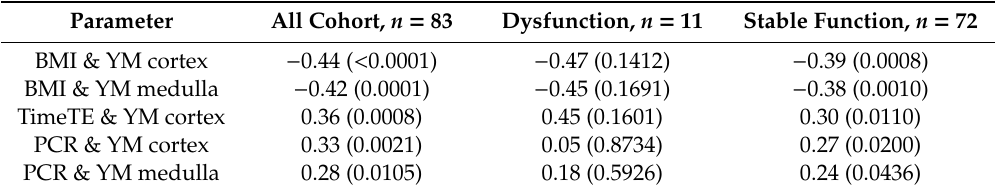
Figure 5. Ultrasound evaluation of a male patient, 27 years old, with normal weight, evaluated at 2005 days after transplant. The kidney allograft function was stable, and the patient was with normal dose of calcineurin inhibitor. The allograft volume was 245 mL, a parenchymal thickness of 12.9 mm, a cortical thickness of 6.3 mm, and normal echogenicity ( a ). Doppler signal was globally present ( b ) with all RIs (RI = resistivity index) lower than 0.7 (0.51 at upper interlobar artery, 0.63 at the medium interlobar artery, and 0.56 at the lower interlobar artery). The SWE elastogram box show homogenous colors around low shiftiness indicating the presence of stiff tissue ( c ) with a median value of YM equal with 37.27 kPa for kidney cortex and 14.31 kPa for kidney medulla and a low variability among measurements on both kidney compartments (QCV equal with 11.13% for cortex and 7.36% for medulla). Table 5. Statistically significant associations between Young’s modulus and demographic and clinical characteristics.